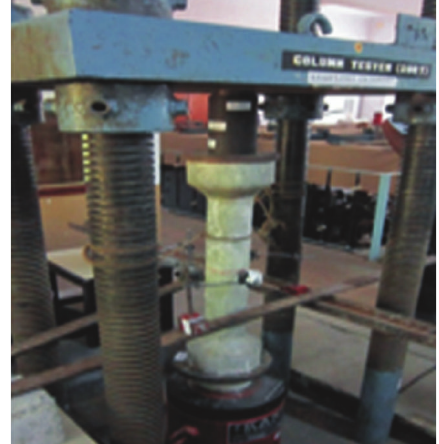
Figure 2: Experimental setup.